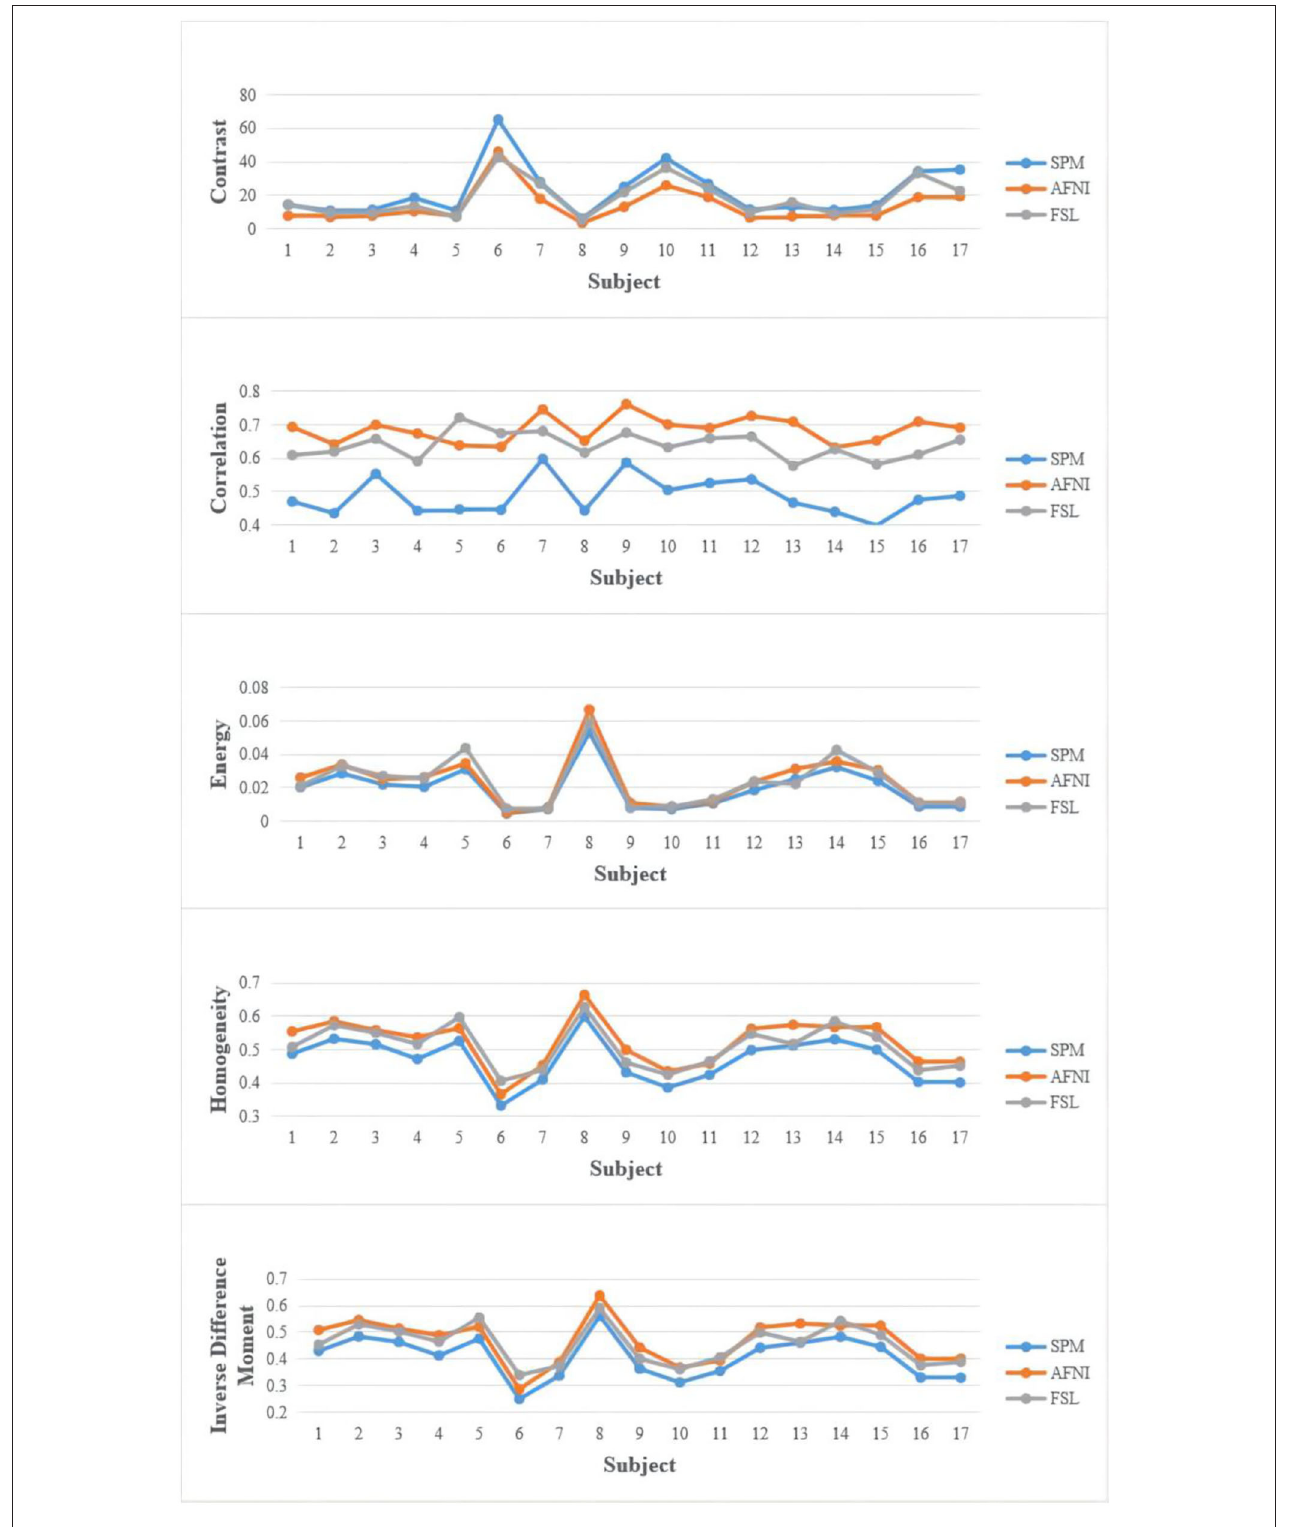
FIGURE 3 | Texture feature extracted from the dataset.